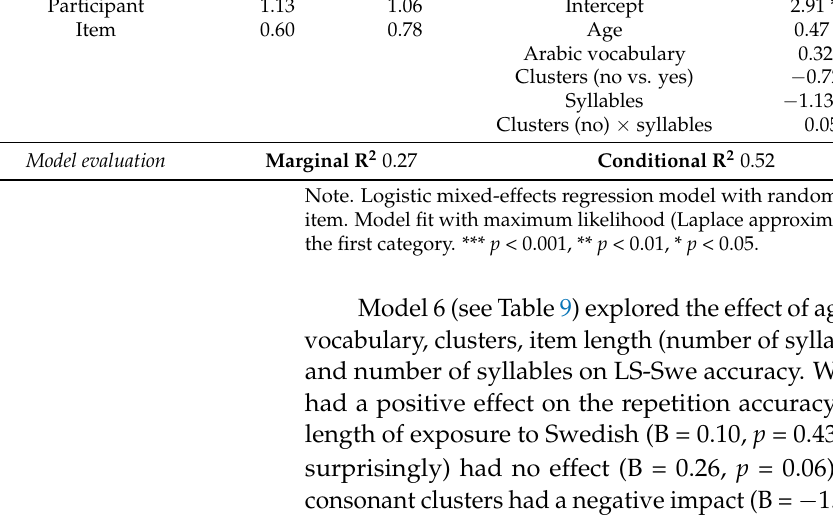
Figure 2. Accuracy (% correct responses) for items in LS-Swe and NWRT-Leb by number of syllables